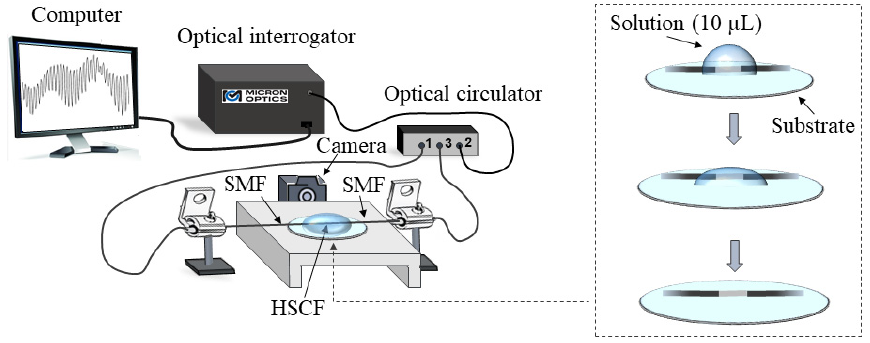
Figure 3. Scheme of the experimental setup.